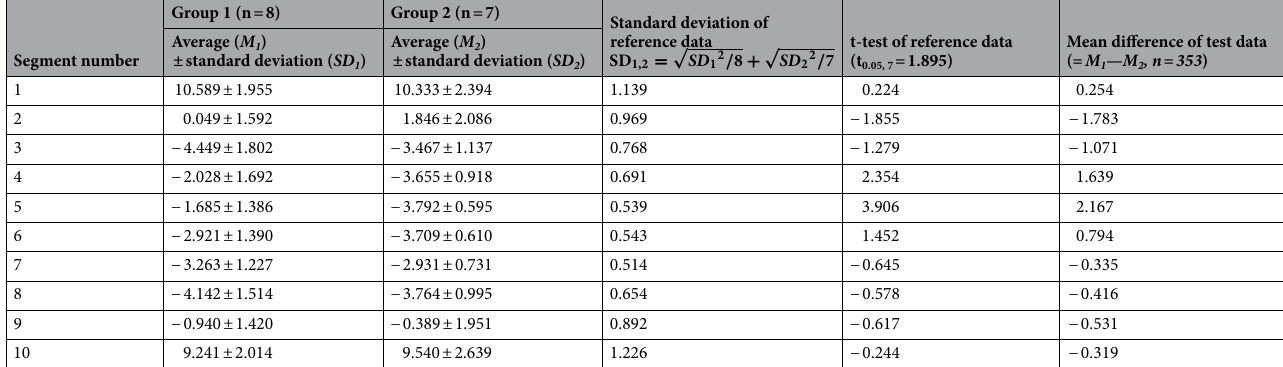
Table 1. Differences in PPG waveforms between the Group 1 and Group